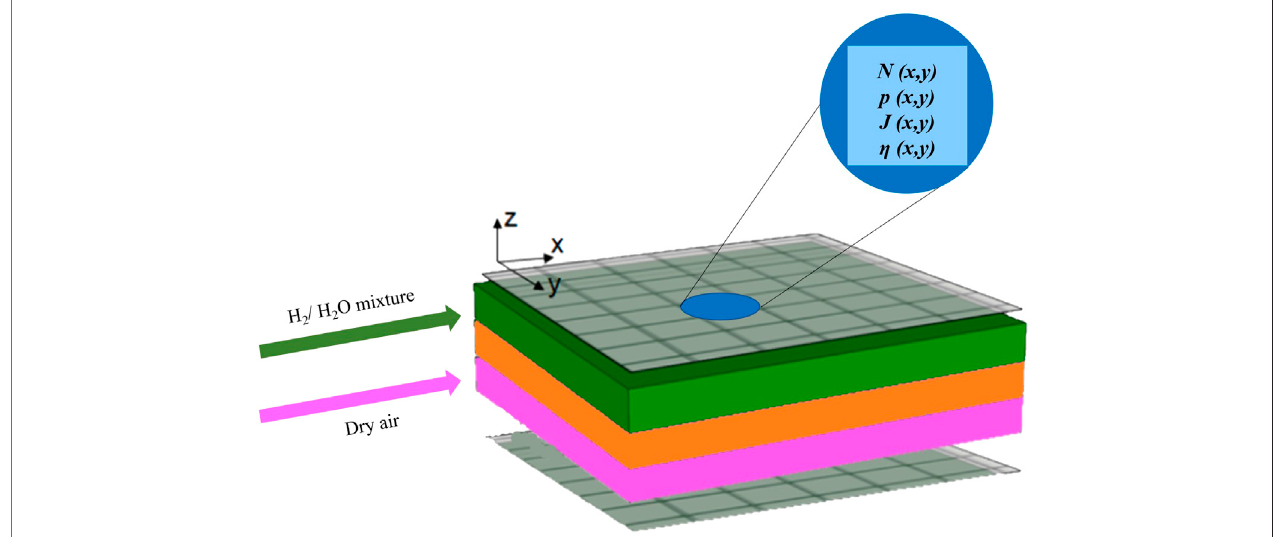
FIGURE 1 | Cell structure consisting in fuel electrode (green), electrolyte (orange) and air electrode (violet), which is modelled through 2D discretization as anodic and cathodic side meshes allowing for local property calculation in each sub-cell.